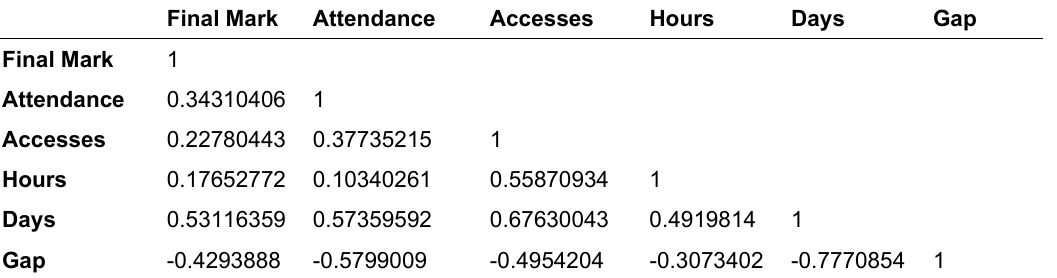
Table 4. Pearson Correlation